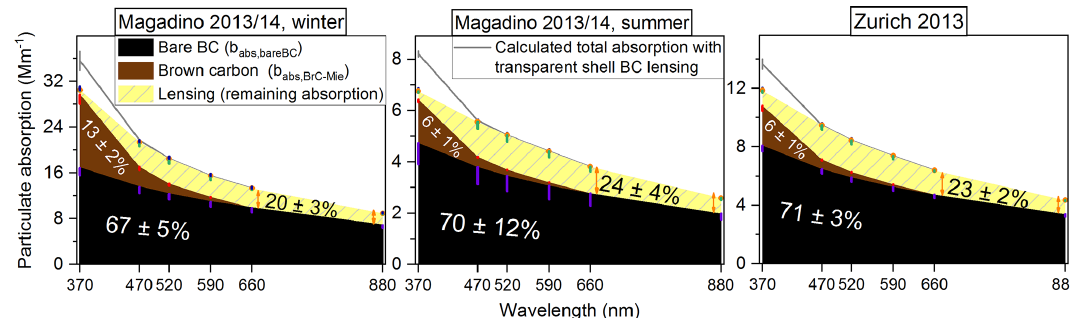
Figure 6. Optical closure results at six AE33 wavelengths ( x axis, linear scale), shown as cumulative contributions (labels) to total (calibrated) measured particulate absorption ( y axis) of the different carbonaceous aerosol species (bare BC, extractable BrC) and the filter-based BC absorption enhancement (lensing) defined as “remaining absorption”. The total measured absorption, b abs , total , is indicated with the orange circles (uncertainty: upward blue error bars). Note the different ranges of b abs values ( y axis) between the three cases. Orange arrows indicate the lensing contribution at longer wavelengths (660, 880nm) for the three cases, with filter-based E abs , BC being equal to (1.35 ± 0.10, 1.33 ± 0.10), (1.37 ± 0.24, 1.38 ± 0.17) and (1.35 ± 0.07, 1.33 ± 0.07) for Magadino winter, Magadino summer and Zurich, respectively. The error bars (minus direction shown; violet: BC; green: BC lensing; red: BrC) were computed by error propagation on the mean values (Eqs. C1–C3) using the C λ (Fig. A1), MAC bareBC , 660nm (Fig. S14), AAE bareBC (Fig. 4a) and b abs , BrC − Mie (Sect. S5) relative errors (Appendix C). The grey line indicates calculated total absorption by adding the absorption by BrC and absorption by BC including transparent shell lensing (assumed to be wavelength-independent) extrapolated from 660nm.